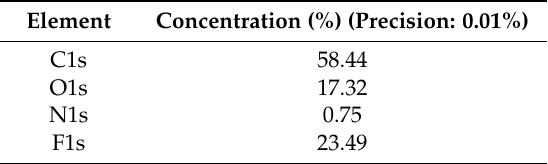
Table 1. Element content of precipitates on spherical electrode surface.